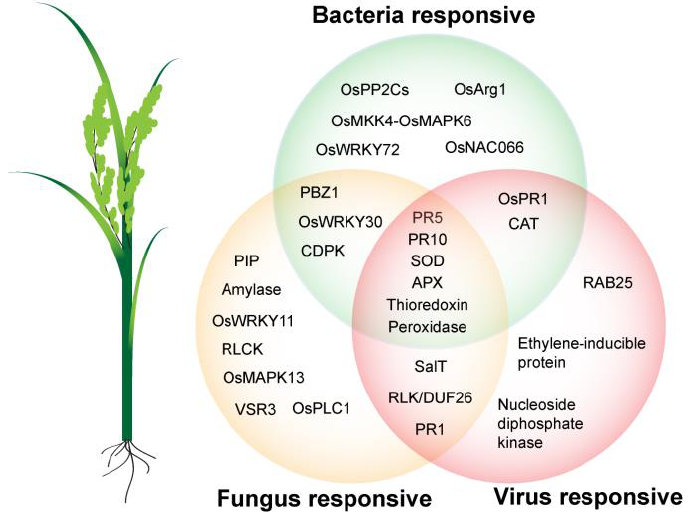
Figure 3. Proteomics investigation of rice–microbe interactions. Interactions between rice and different types of microbes, including pathogenic bacteria, symbiotic bacteria, fungi, and viruses, have been investigated with proteomics approaches in recent decades. Proteome results indicate that the ascorbate peroxidase (APX), superoxide dismutase (SOD), peroxidases, pathogenesis-related (PR) protein PR5, PR10, and thioredoxin are identified in response to bacteria, fungi, and viruses, while probenazole-induced protein (PBZ1), OsWRKY30, and calcium-dependent protein kinase (CDPK) are responsive only to bacterial and fungal pathogens. Salt-induced protein (SalT), receptor-like kinase/domain of unknown function 26 (RLK/DUF26), and PR1 are induced upon fungal and viral infections. OsPR1, heat-shock proteins (HSPs), and catalase [21] are induced by bacteria and viruses. A group of proteins specific to bacteria, fungi, and viruses has also been identified. OsPP2C, protein phosphatase 2C; OsMKK4, mitogen-activated protein kinase kinase 4; OsMPK6, mitogen-activated protein kinase 6; VSR3, vacuolar sorting receptor 3; PIP, plasma membrane intrinsic proteins; RAB25, and ras-related protein 25.